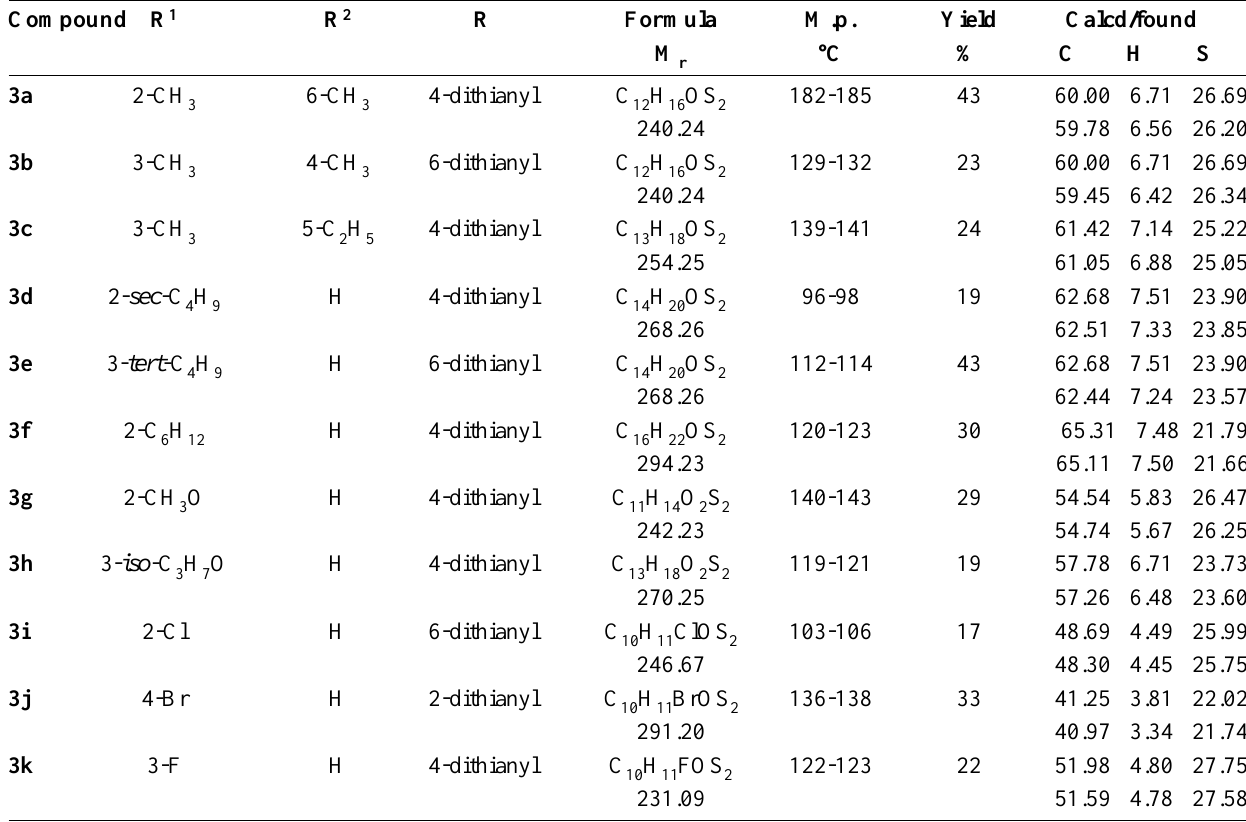
Table 1. Physicochemical data of compounds 3a-k. The given positions in numbers of the groups are relative to the OH group. Compound R